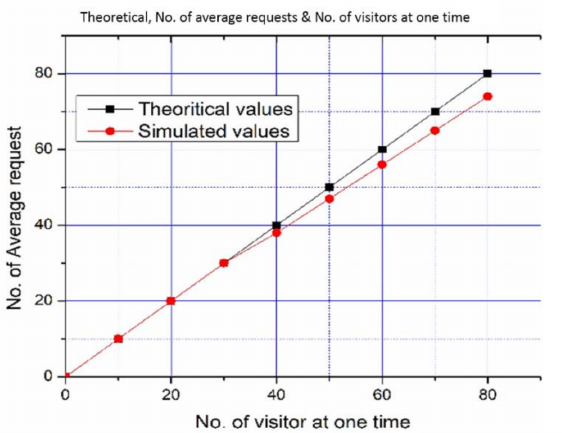
Figure 21. SNIS performance with 960 Objects and 80 Visitors.